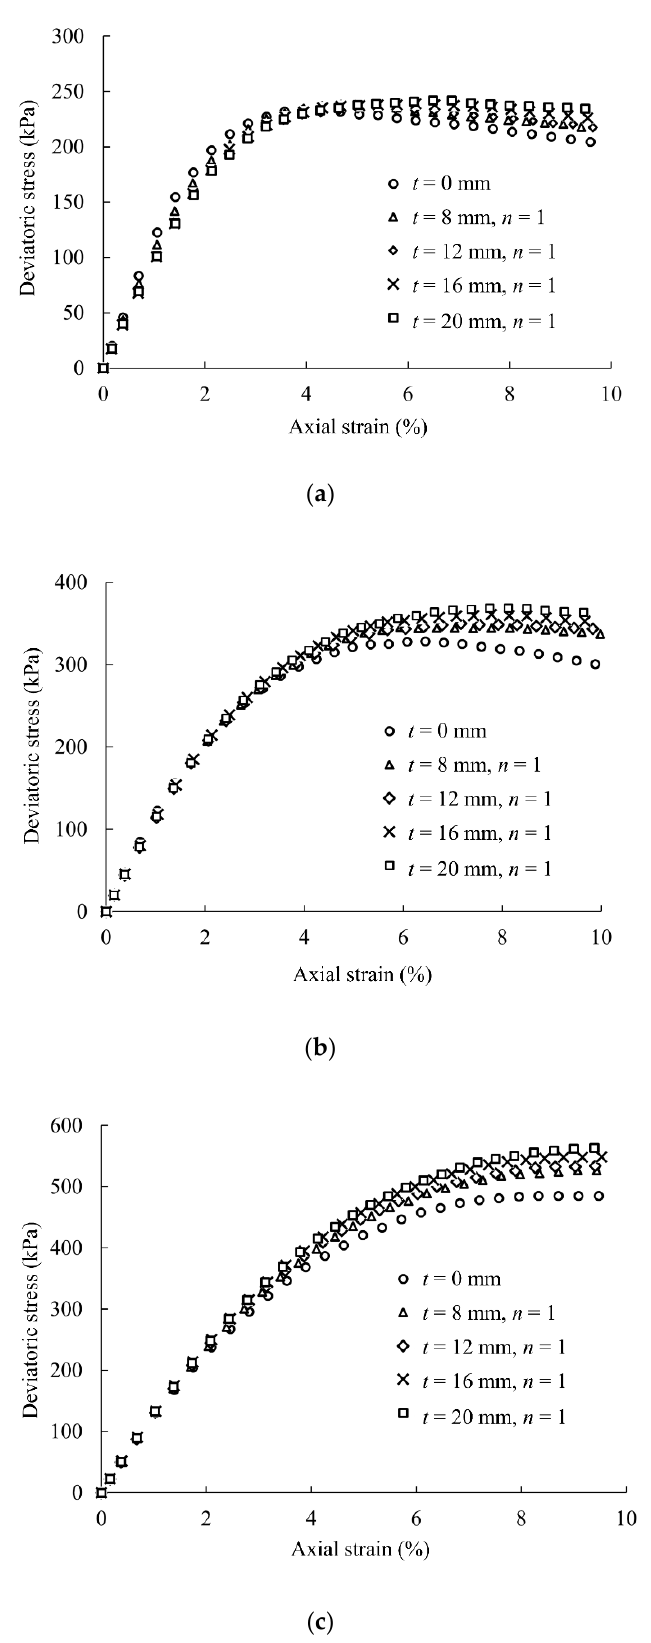
Figure 8. The deviatoric stress–axial strain curves of the SCL samples at different thicknesses of sand layers and confining pressures of ( a ) 150 kPa, ( b ) 250 kPa, and ( c ) 400